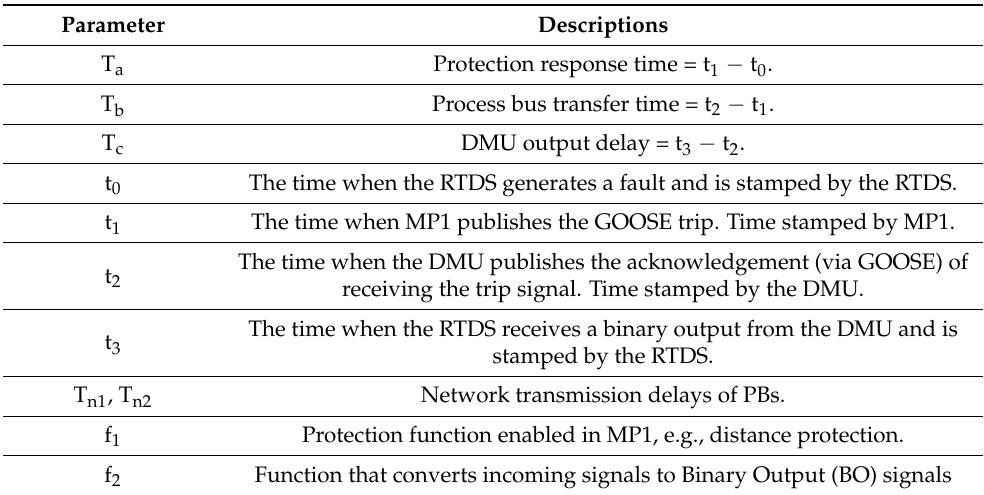
Figure 6. Example of time stamps captured by the visualisation tool. Table 1. Time delay and function